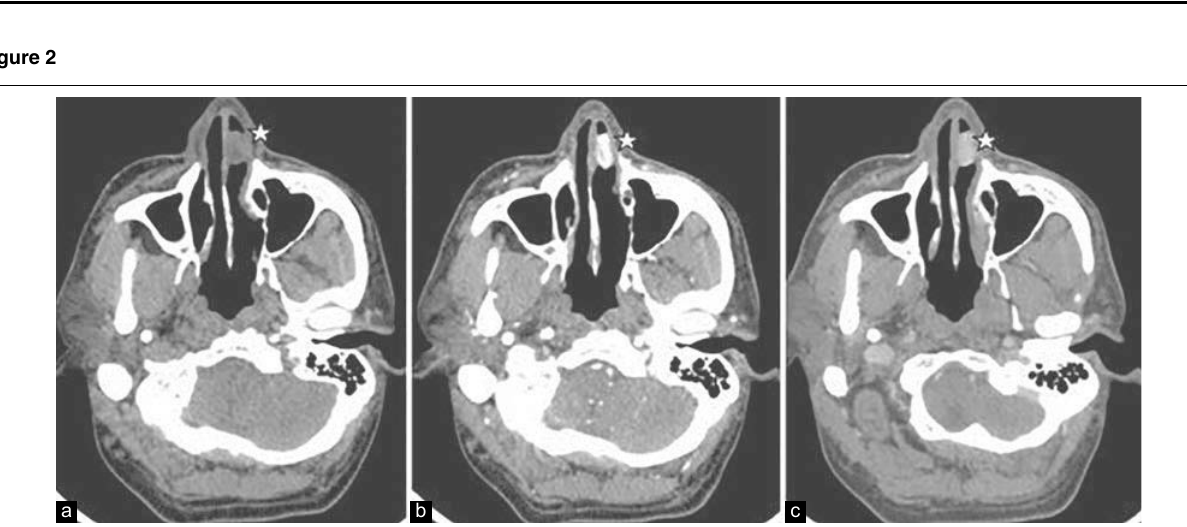
(a–c) Axial plain and contrast-enhanced computed tomographic images of the paranasal sinus in arterial and venous phase show a well-de (cid:383) ned intensely enhancing polypoidal mass lesion involving the cartilaginous nasal septum